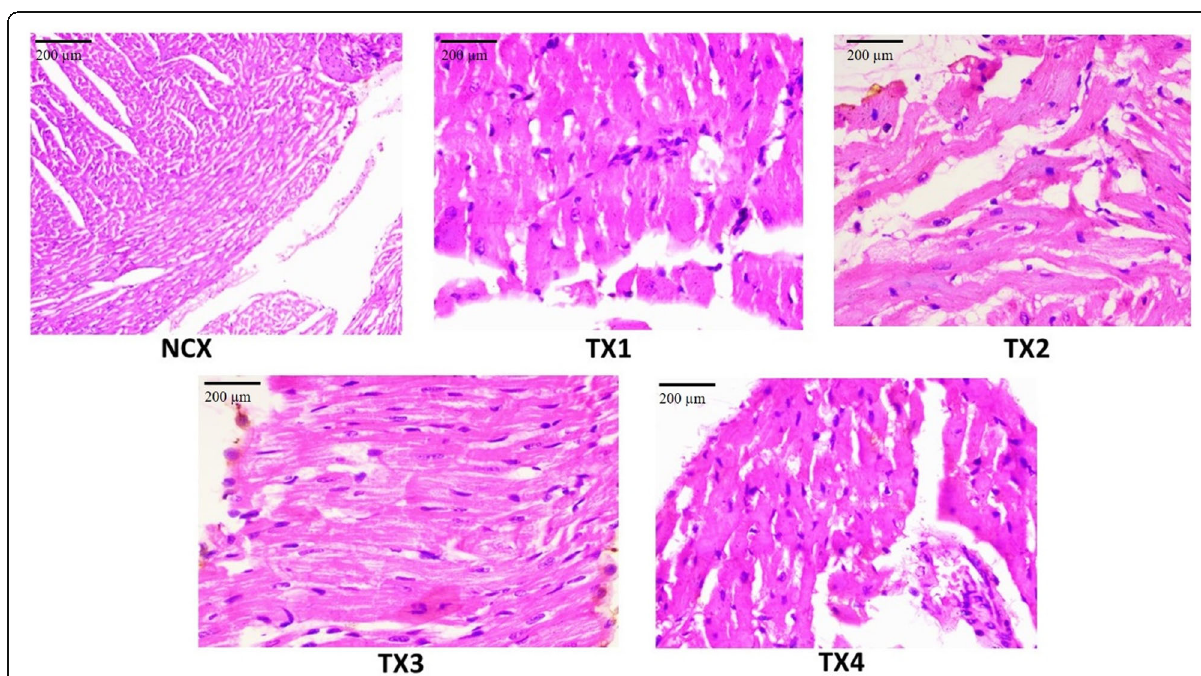
Fig. 1 The histopathology of heart from the different group of swiss albino mice (40 × magnification; Scalar bar: 200 μ m). The microscopic analysis of the heart in all treatment groups displayed normal architecture of the cardiac muscle fibers with intact length and regular cell striation and nuclei and was bereft of significant cellular infiltration or degeneration when compared to normal control group (NCX). Where NCX: Normal control group; TX1: Sub-acute toxicity group 1 (250 mg/kg/day/p.o); TX2: Sub-acute toxicity group 2 (500 mg/kg/day/p.o); TX3: Sub-acute toxicity group 3 (1000 mg/kg/day/p.o); TX4: Sub-acute toxicity group 4 (2000